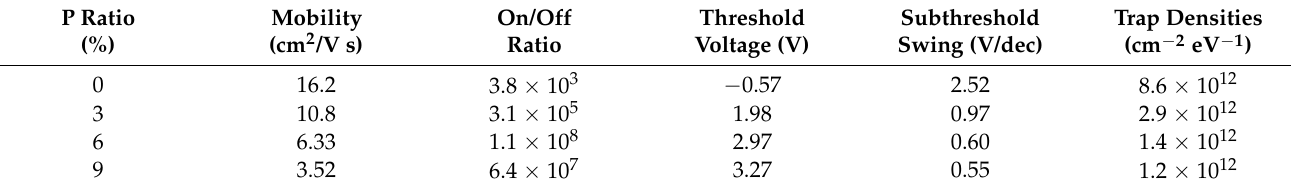
Table 2. Summary of electrical properties of IPO TFTs investigated.